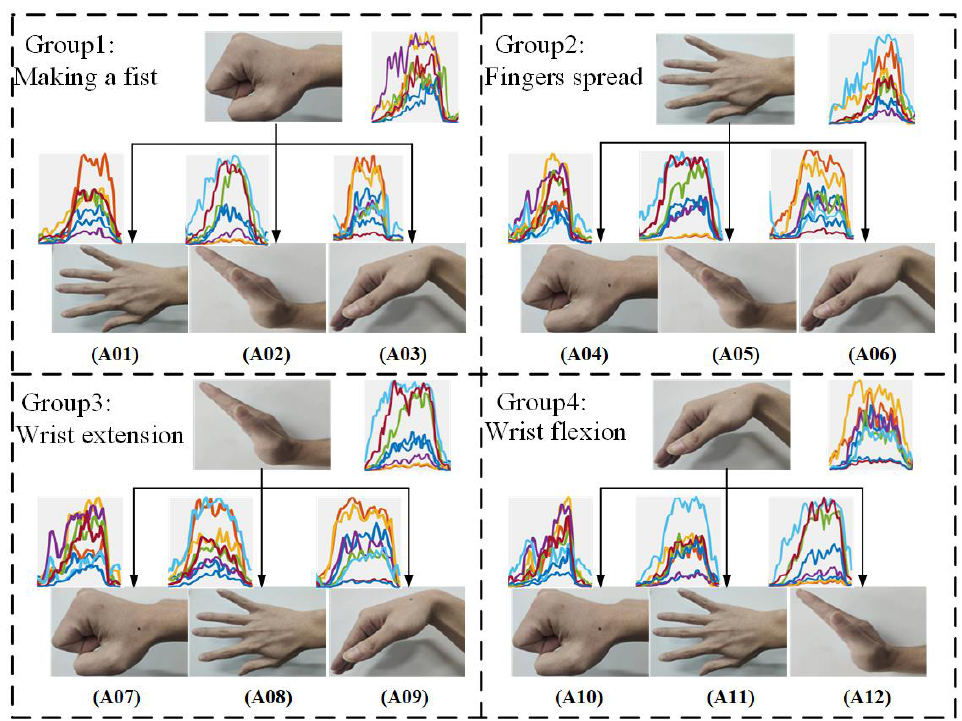
Figure 3. Illustration of continuous two-hand actions; four groups are determined by different starting hand gestures. Table 1. Configuration of the